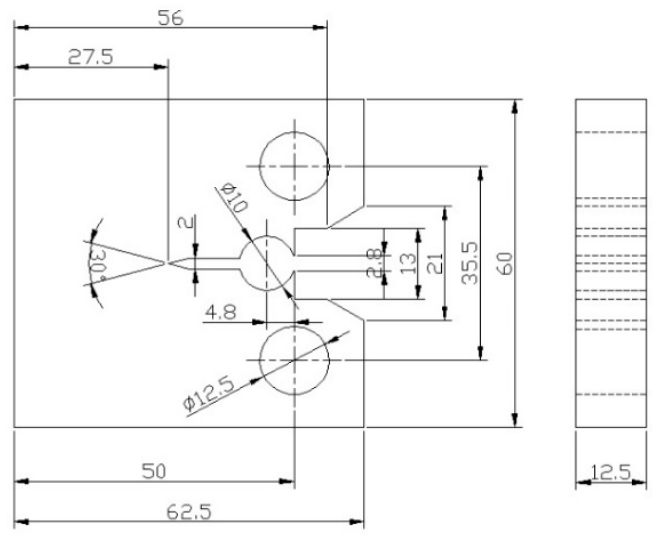
Figure 7. Specimen configuration for crack growth rate test.